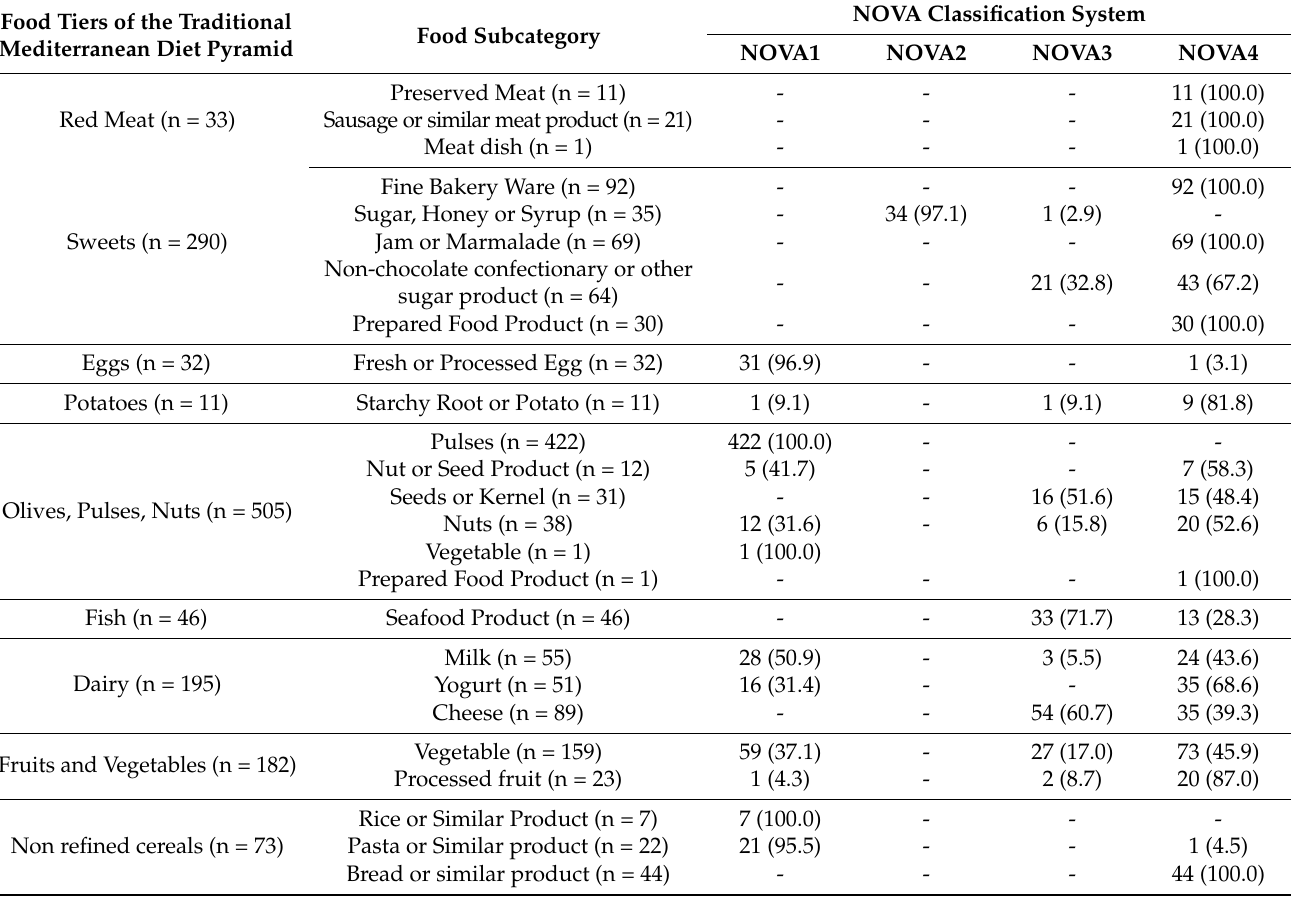
Table 2. Distribution of NOVA groups among food subcategories of the traditional MD pyramid tiers.